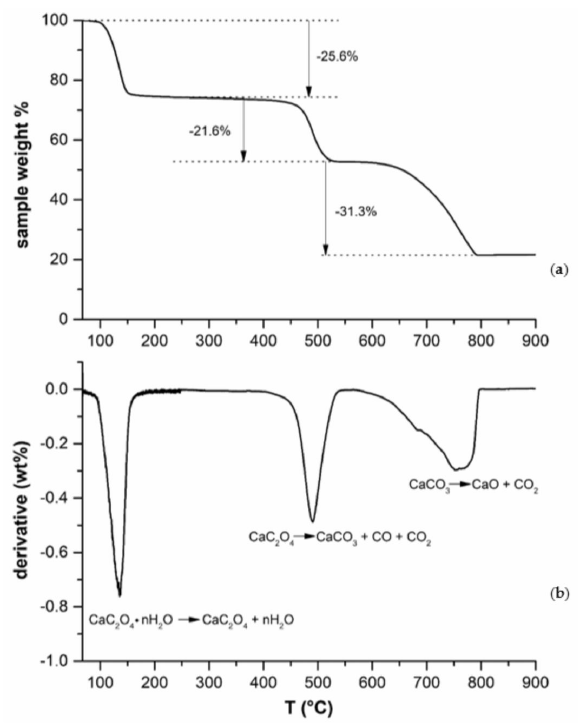
Figure 4. Thermogram ( a ) and the first derivative ( b ) showing the endothermic peaks related to the reactions indicated in